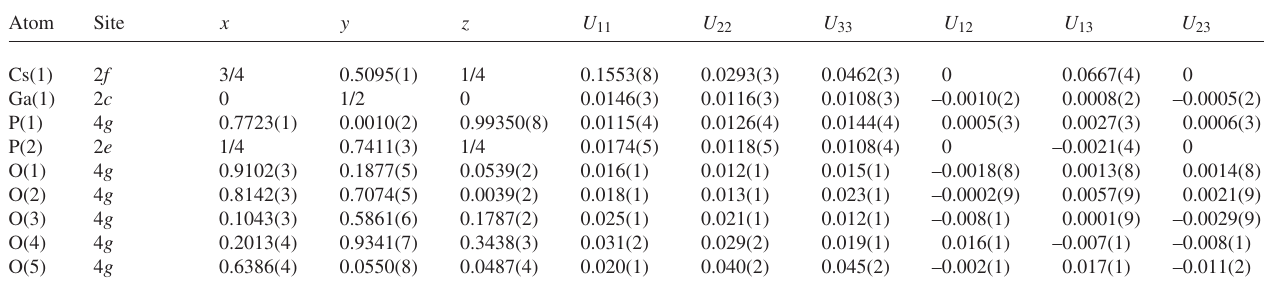
Table 3. Atomic coordinates and displacement parameters (in Å 2 ) .